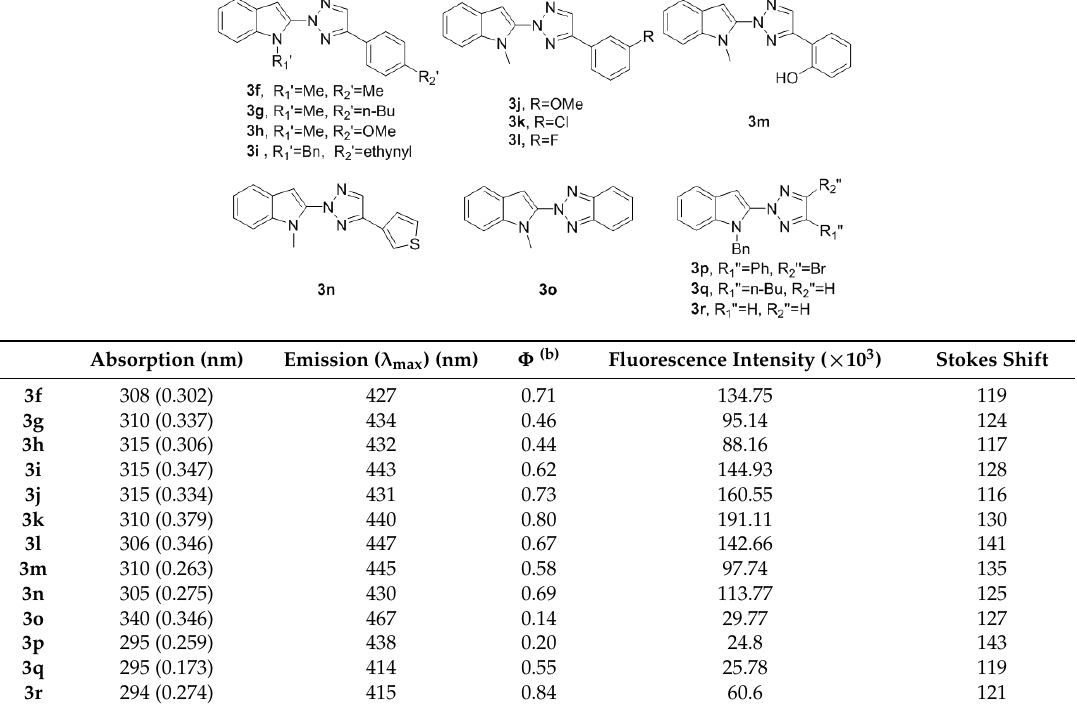
Table 2. Fluorescence emission behavior of compounds with different triazole-substitutions (a) .